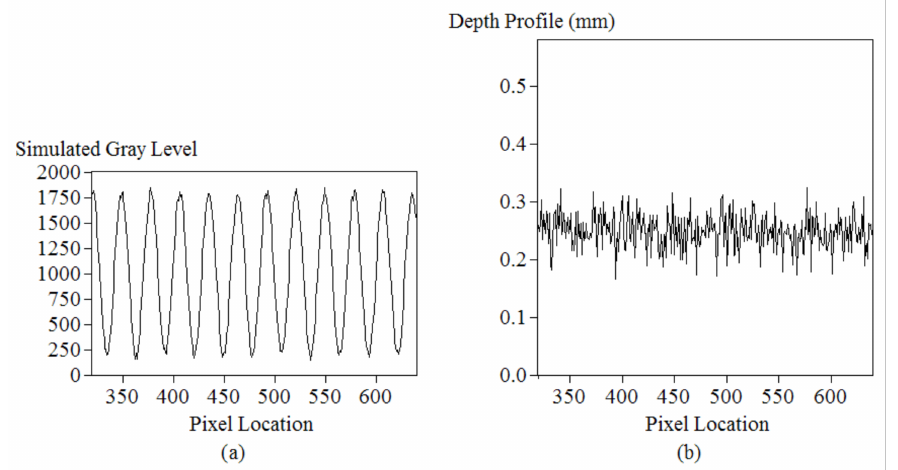
Figure 14. ( a ) Simulated 1D distribution for the first sinusoidal projection by adding white noises with SNR = 40. ( b ) Retrieved 1D profile from the simulated fringe